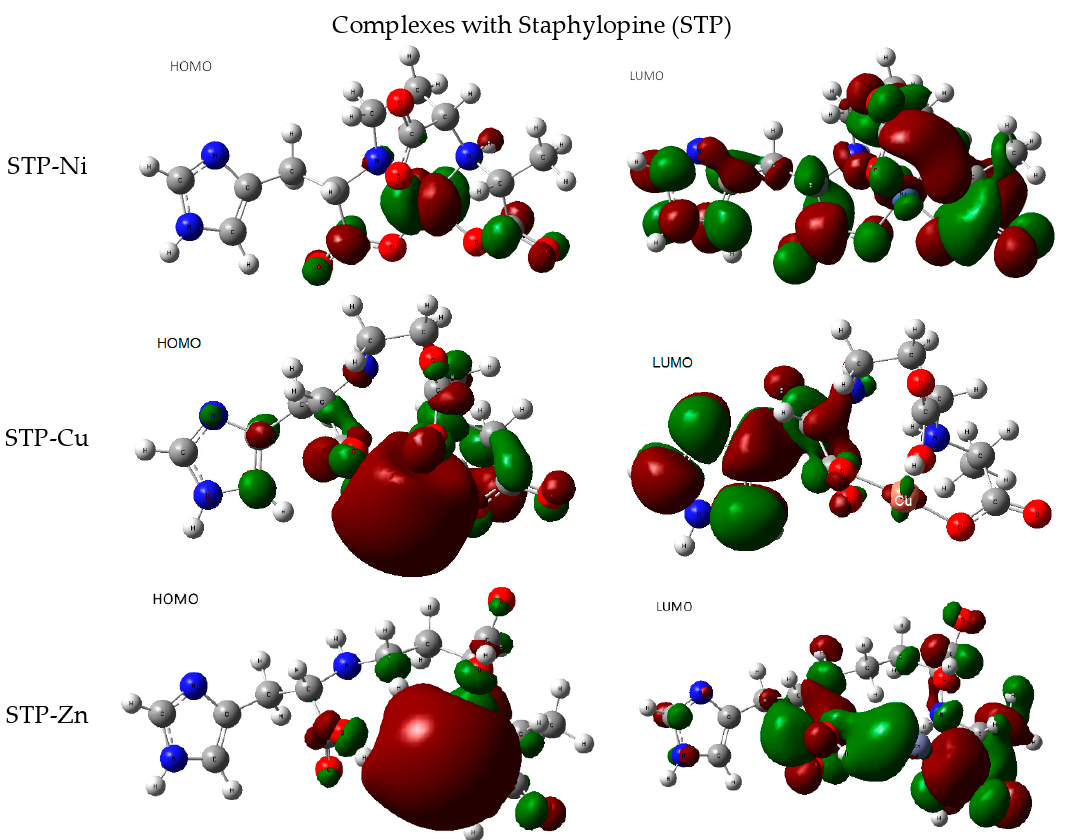
Figure 7. HOMOs and LUMOs of transition-metal complexes with STP (Ni, Cu, and Zn).